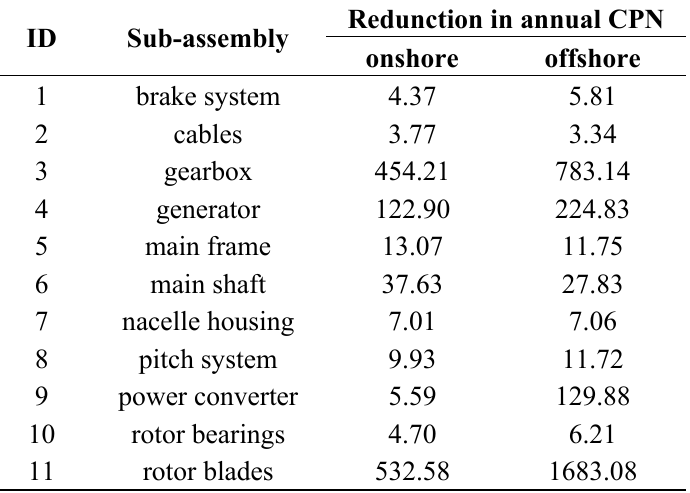
Table 13. Reduction in the annual CPN by ten percent improvement in fault